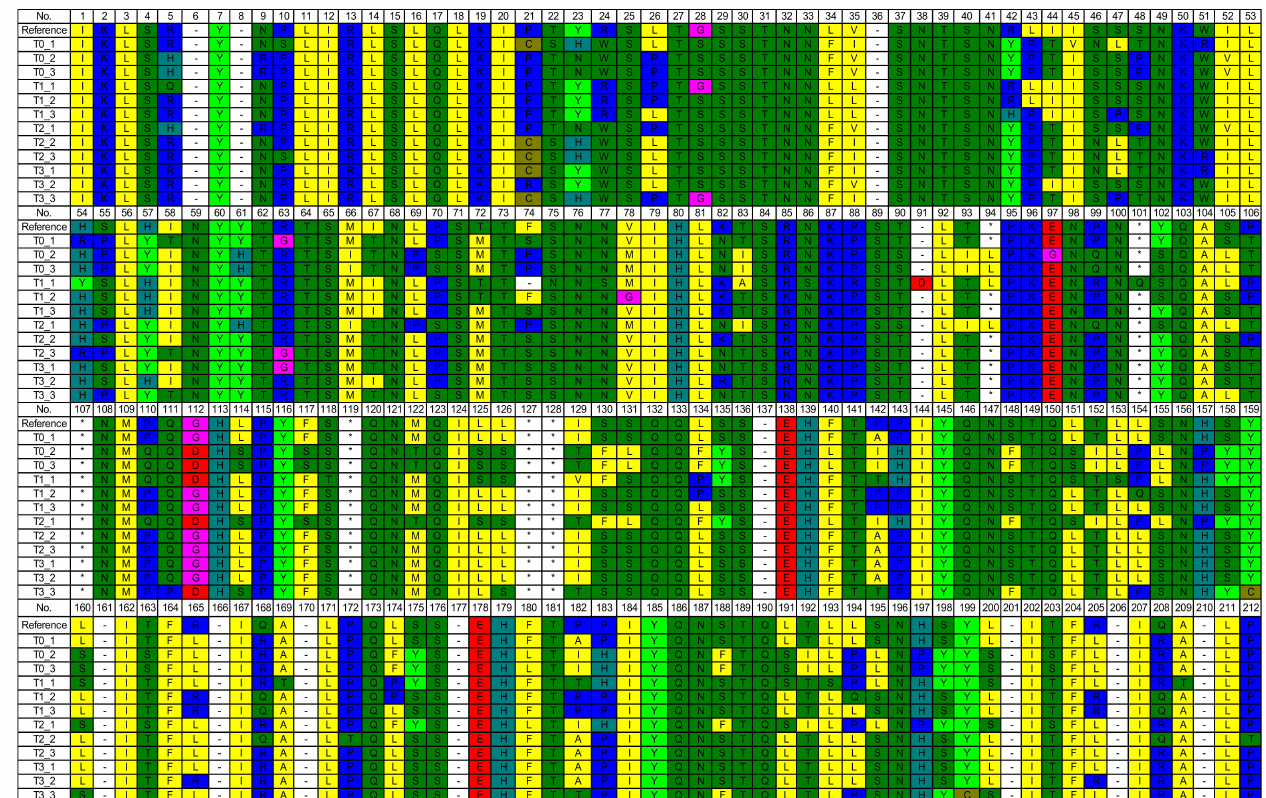
Figure 3. Amino acids encoded by nicotinamide adenine dinucleotide hydride (NADH) dehydroge- nase 1 (ND1) of mitochondrial deoxyribonucleic acid (mtDNA)